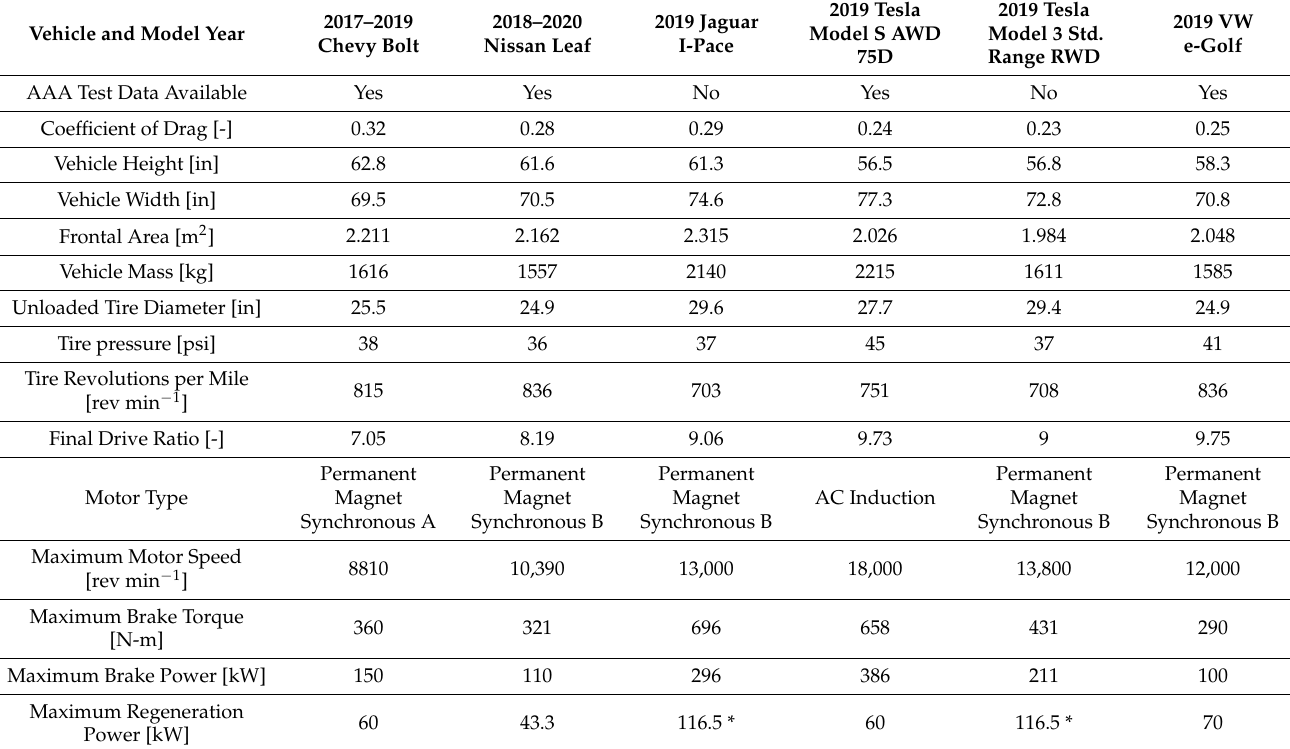
Table A1. Pertinent vehicle parameters for six commercial